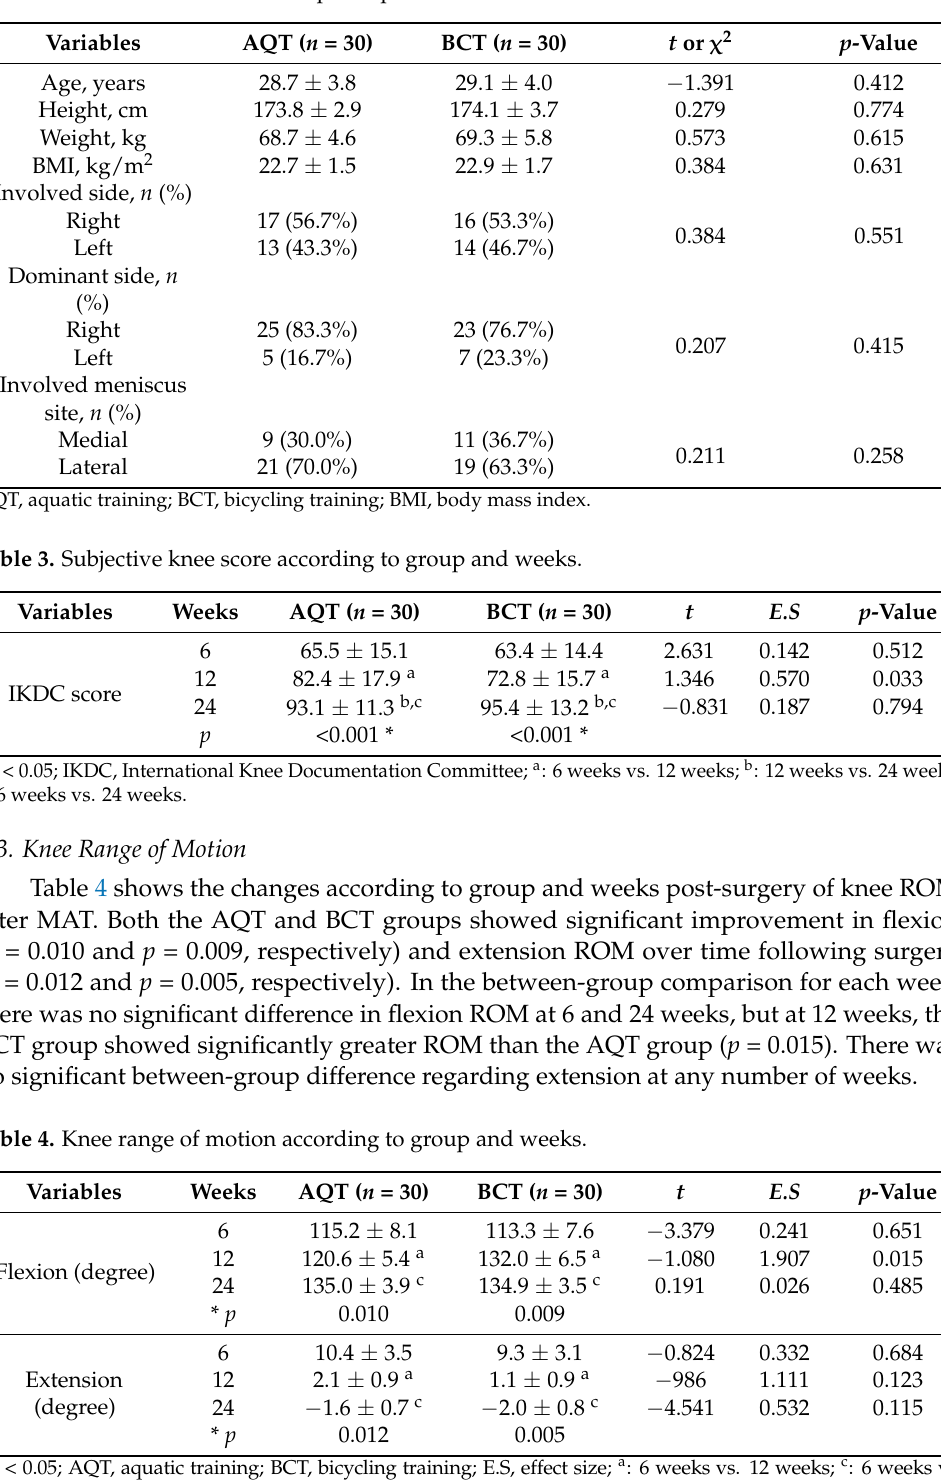
Table 2. General characteristics of participants.